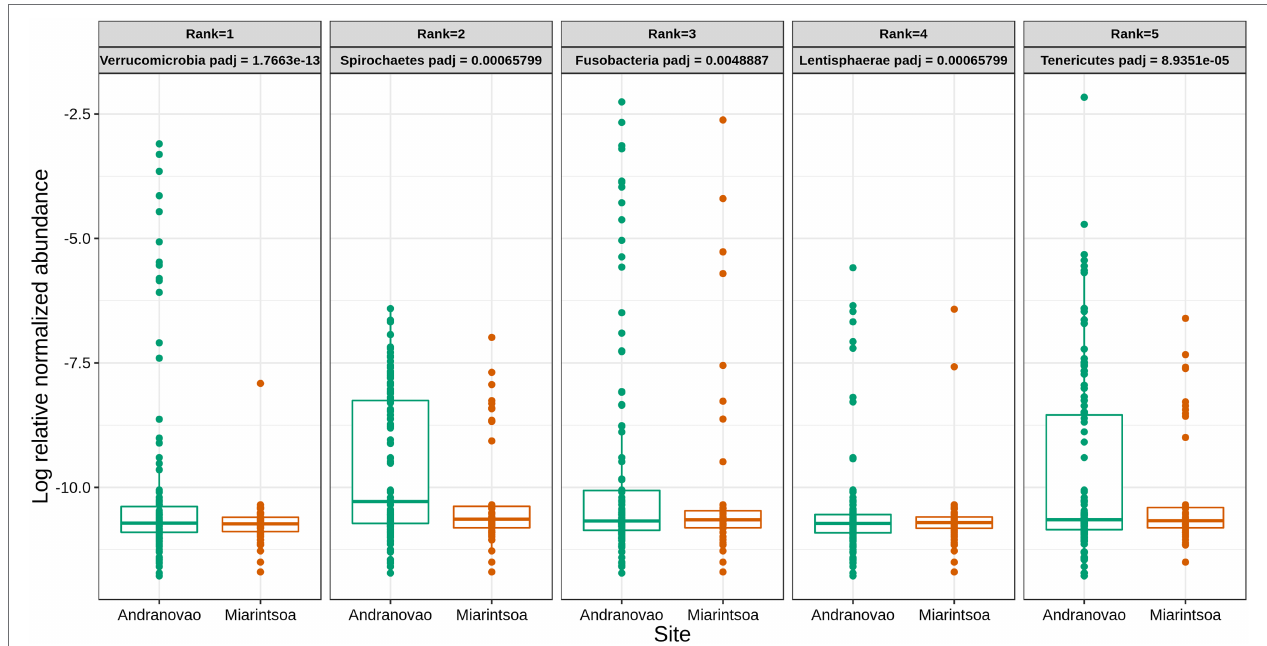
FIGURE 4 | Relative abundance of major bacterial phyla in gut of mouse lemurs differs between habitats. Box plots indicate the effect of study site (Andranovao in green; Miarintsoa in red) on the relative abundance of major phyla in the gut microbiomes of mouse lemurs (all p < 0.01). Phyla are arranged according to the assigned rank based on the importance of differentially abundant phyla (see “Materials and Methods” for